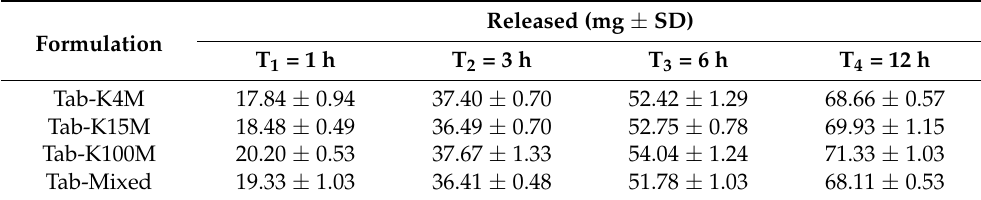
Figure 7. In vitro release of PNL from compressed HPMC-based matrix tablets. Table 2. The total amount of PNL released at each time point from compressed HPMC-based matrix